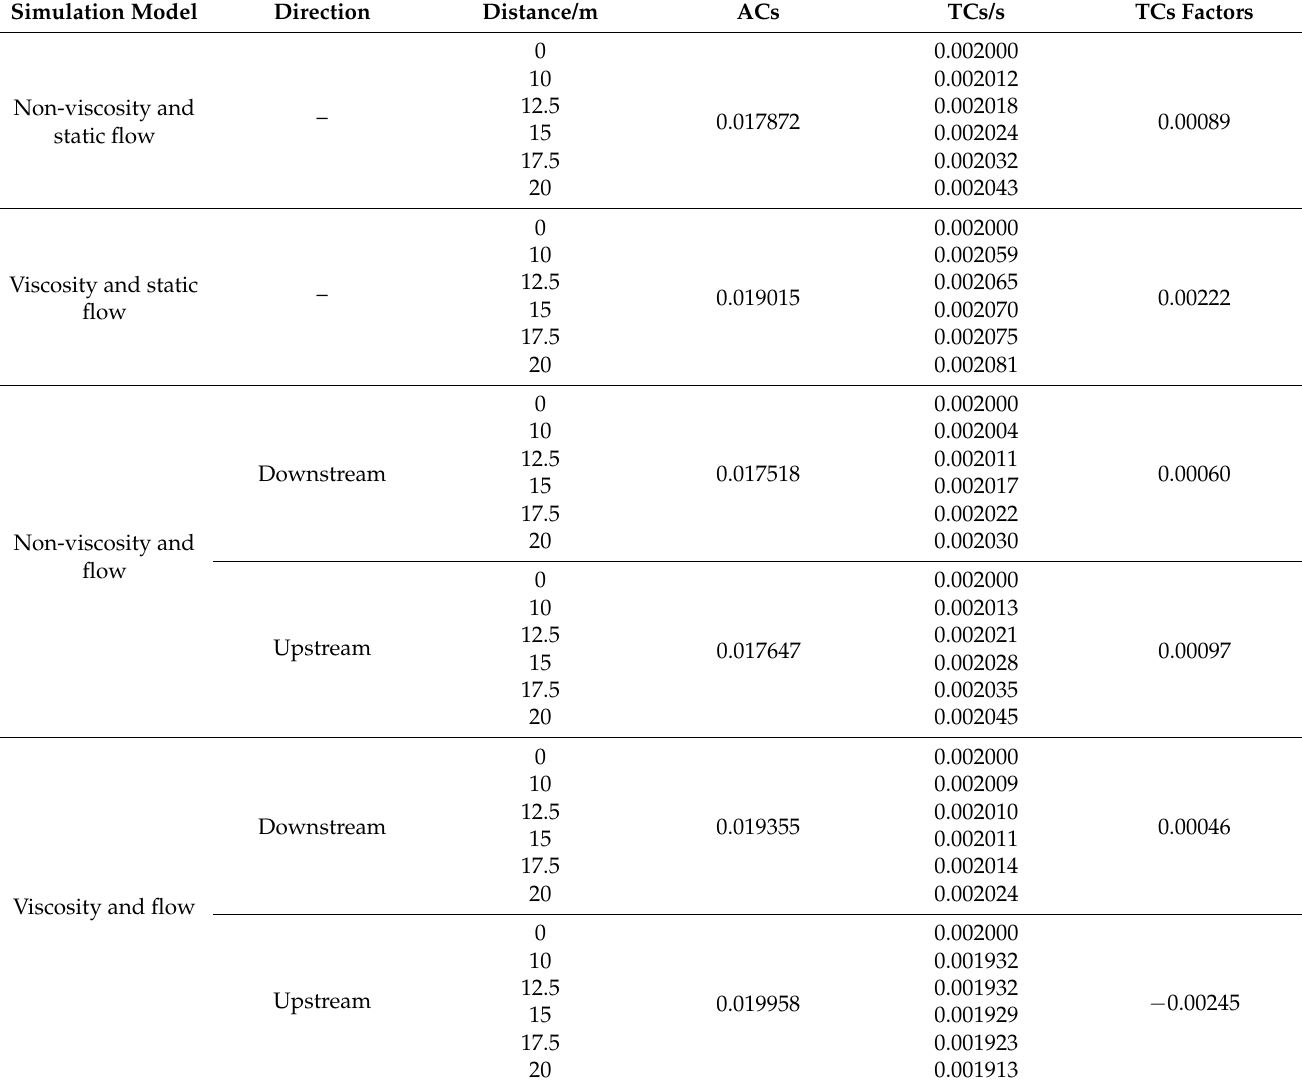
Table 8. Propagation characteristics obtained by different simulation